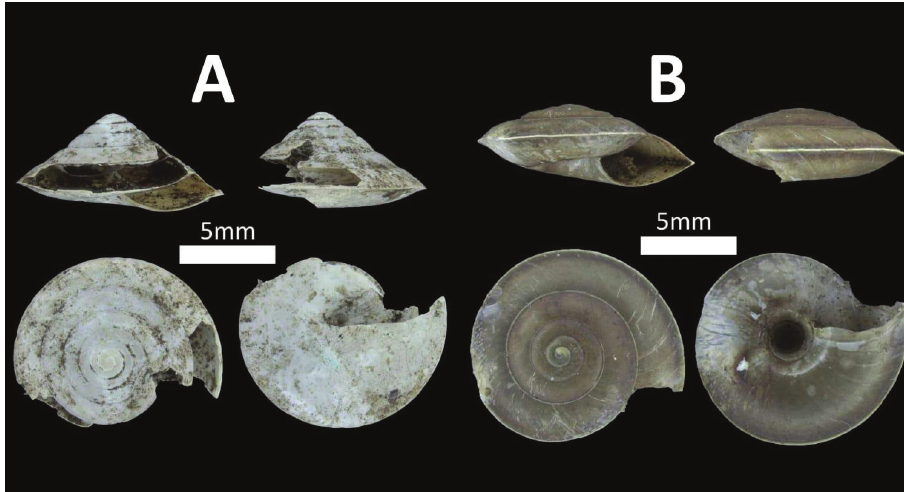
Figure 21. Family Trochomorphidae. A Geotrochus conicoides (BOR/MOL 899) *Broken shell B Videna metcalfei (BOR/MOL